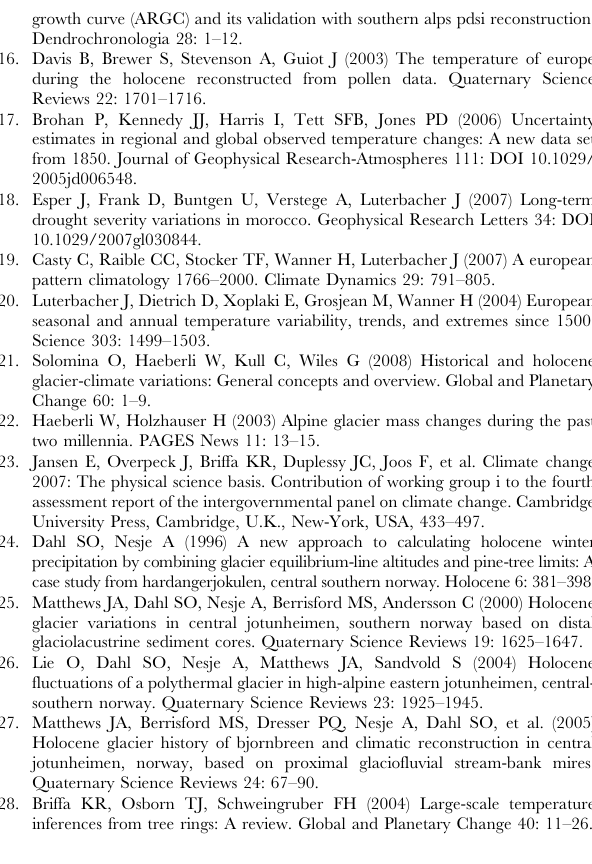
Figure S5 Scheme of the spectral characteristics of the proxies and temperature series: double red arrows indicate the frequency range of each proxy type in number of cycles per year. Found at: doi:10.1371/journal.pone.0009972.s012 (1.66 MB TIF) Figure S6 Proportion of variance in common between years separated by various lags from 0 to 30 (squared autocorrelation function). 0-lag represents the standardised variance, i.e. 1. The horizontal line represents the 50% variance. Figure S7 Estimates versus observations for the first PC of the HADCRUT3 April to September temperature series in the three frequency bands. Blue dots are data used for calibration and red dots data used for the h-block Jack-knife (leave 1-block out) verification. (a) in the low frequency domain, (b) in the middle frequency domain, (c) in the high frequency domain, (d) recombined estimated series (black) and observations (red) in function of time; the green line is the tendency. Figure S8 April to September temperature anomalies averaged on Europe: observation (red) versus estimates (black); (a) in the low frequency domain, (b) in the middle frequency domain, (c) in the high frequency domain. Figure S9 Spatial distribution of R, R2, RE and MPI95 (see text). Figure S10 Comparison, on the reference period 1850–2007, of the reconstructed and observed April to September temperature